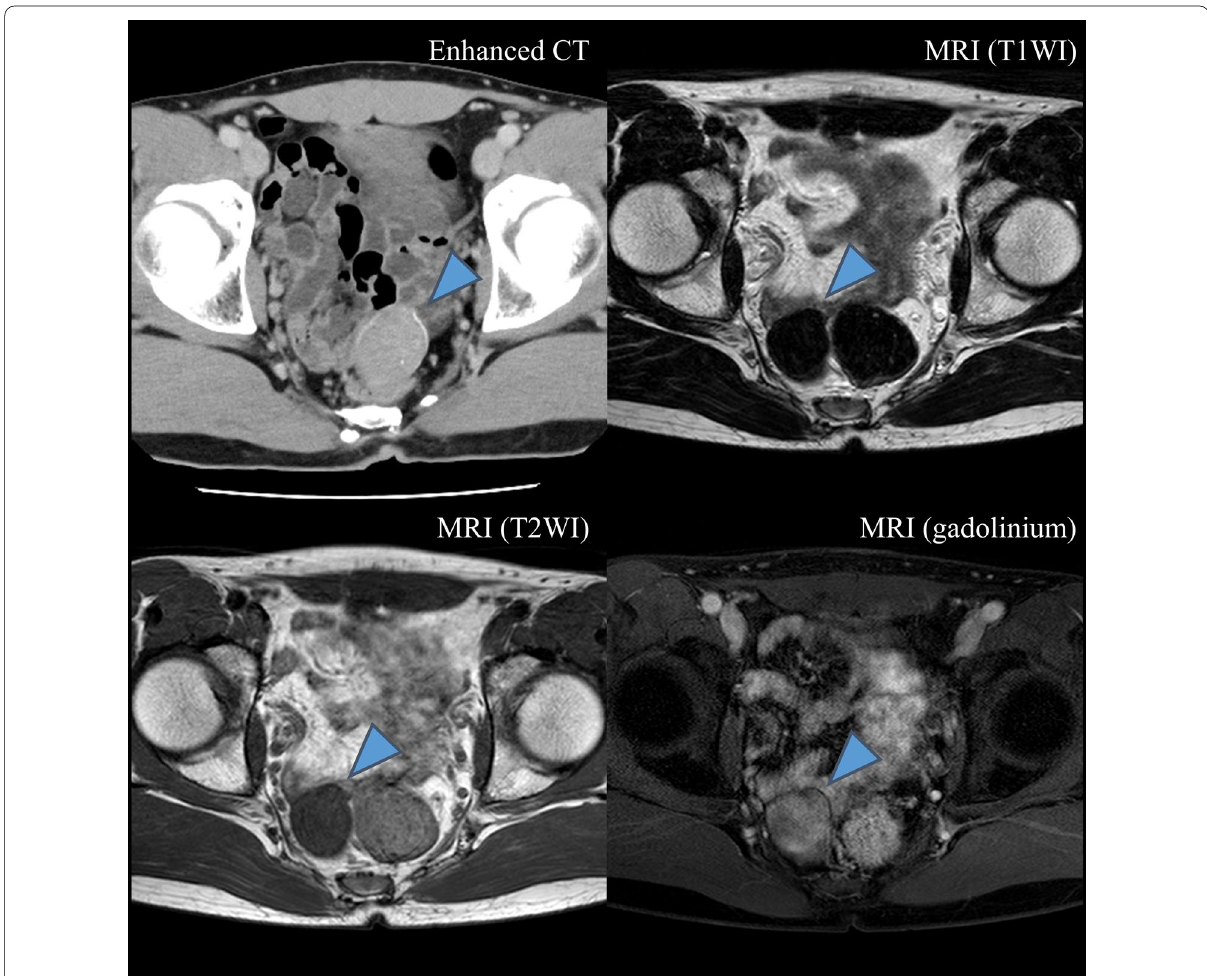
Fig. 1 CT and MRI images. A 45-mm-sized mass (blue arrow head) with partial calcification was observed in the ileum on enhanced CT. The mass was hypointense signal on both T1WI and T2WI, and isointense signal on gadolinium-enhanced T1WI. CT computed tomography, MRI magnetic response image, T1WI T1-weighted image, T2WI T2-weighted